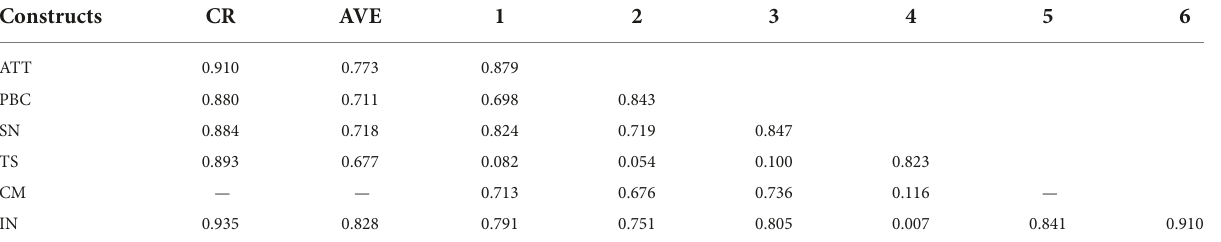
TABLE 3 The results of discriminant and convergent validities.